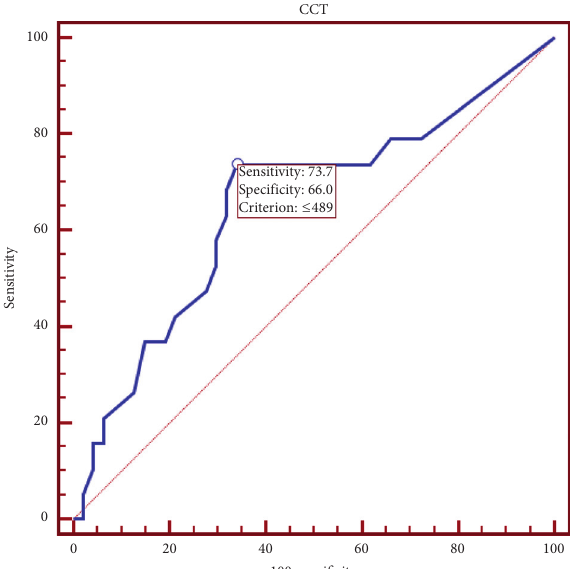
Figure 7: Central corneal thickness (CCT) receiver operating characteristic